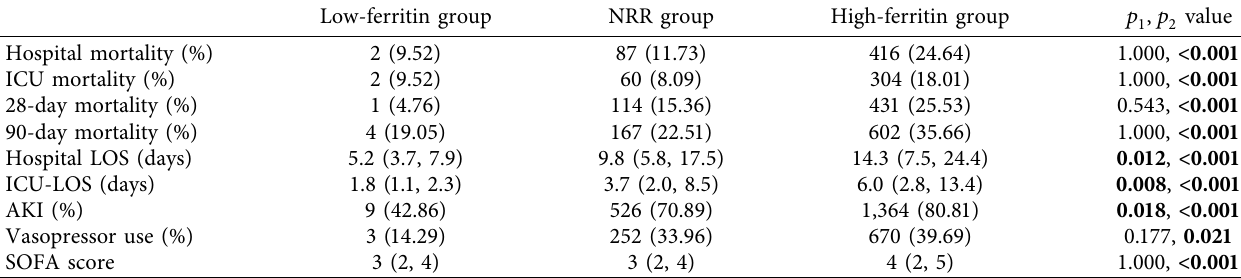
Table 2: Unadjusted relationships between serum ferritin groups and clinical